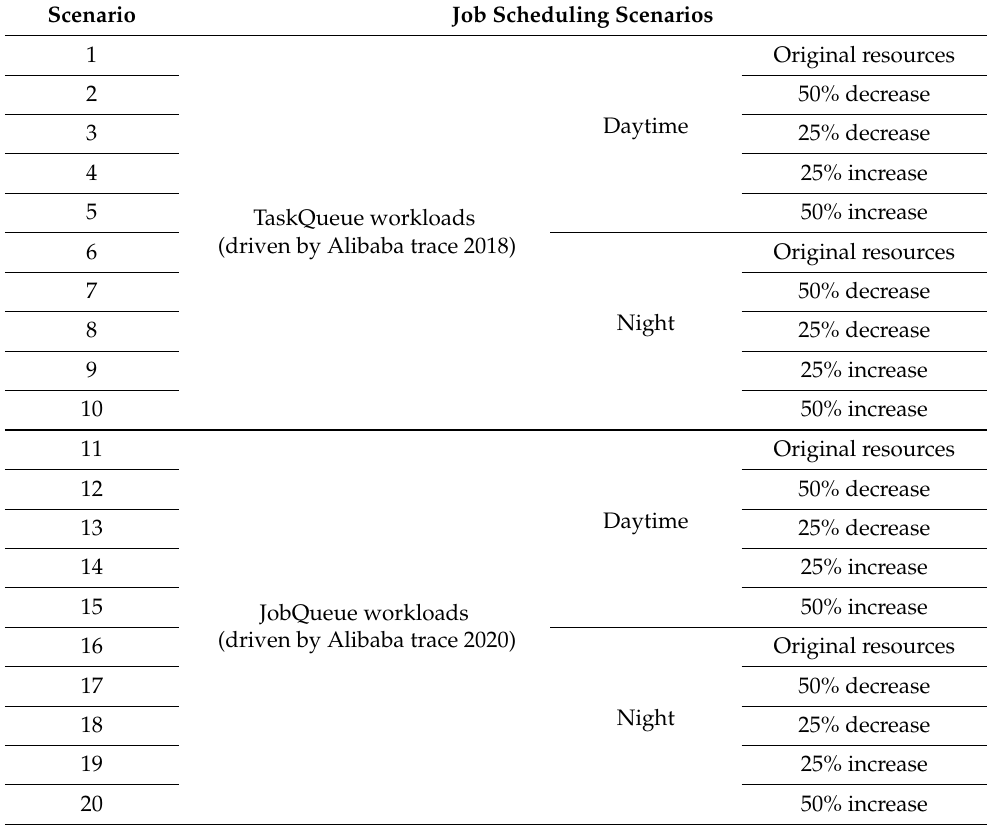
Table 1. Job scheduling scenarios of